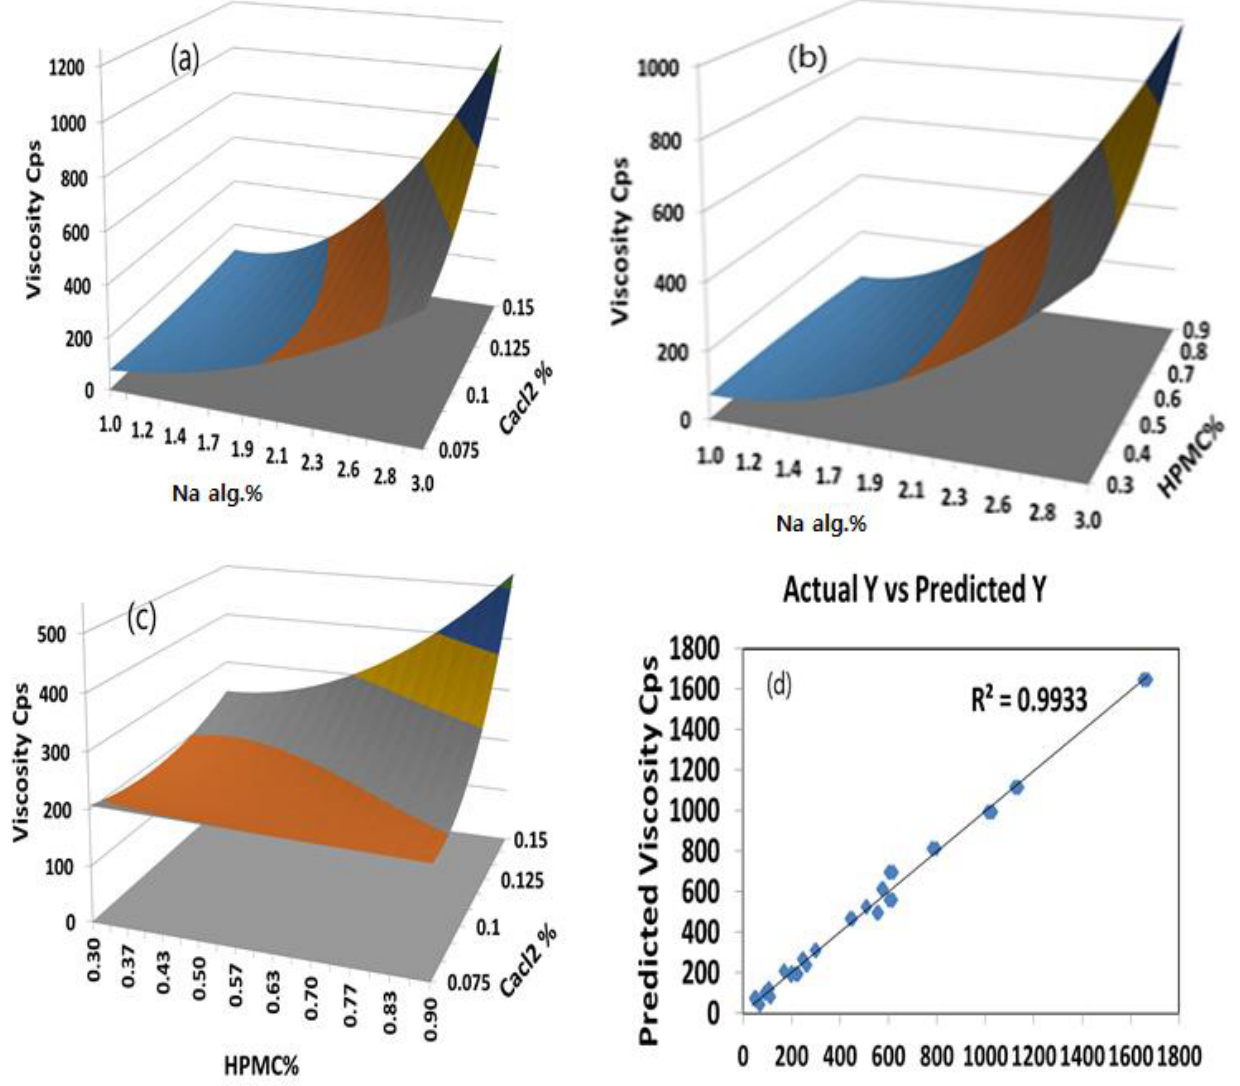
Figure 4. ( a ) Y-hat surface plot showing the effect of X 1 and X 3 on Y 1 at constant X 2 = 0; ( b ) Y-hat surface plot showing the effect of X 1 and X 2 on Y 1 at constant X 3 = 0; ( c ) Y-hat surface plot showing the effect of X 2 and X 3 on Y 1 at constant X 1 = 0; ( d ) linear correlation plot showing predicted against actual values to demonstrate the influence of independent variables X 1 , X 2 , and X 3 on viscosity cP. As far as the percentage of the drug released after 6 h is concerned, the effects of the interaction of each pair of factors on the percentage of the drug released after 6 h at a fixed level of the third one (medium level) are shown in Figure 5. It was determined from the surface plots that a lower value of Y 2 could be obtained with an X 1 level ranging from 1.8 to 3% in combination with an X 2 level ranging from 0.36 to 0.9%, at a medium level of X 3 and in combination with an X 3 level in the range of 0.09 to 0.15%, and at a medium level of X 2 with a percentage of drug released after 6 h ranging from 40% to 48%. It was obvious that the sodium alginate concentration contributed more than the HPMC and CaCl 2 concentra- tions to controlling the percentage of the drug released after 6 h from the formulation. The percentage contribution of the sodium alginate concentration was found to be 65.43% versus 15.61% for the HPMC concentration and 14.82% for the CaCl 2 concentration.